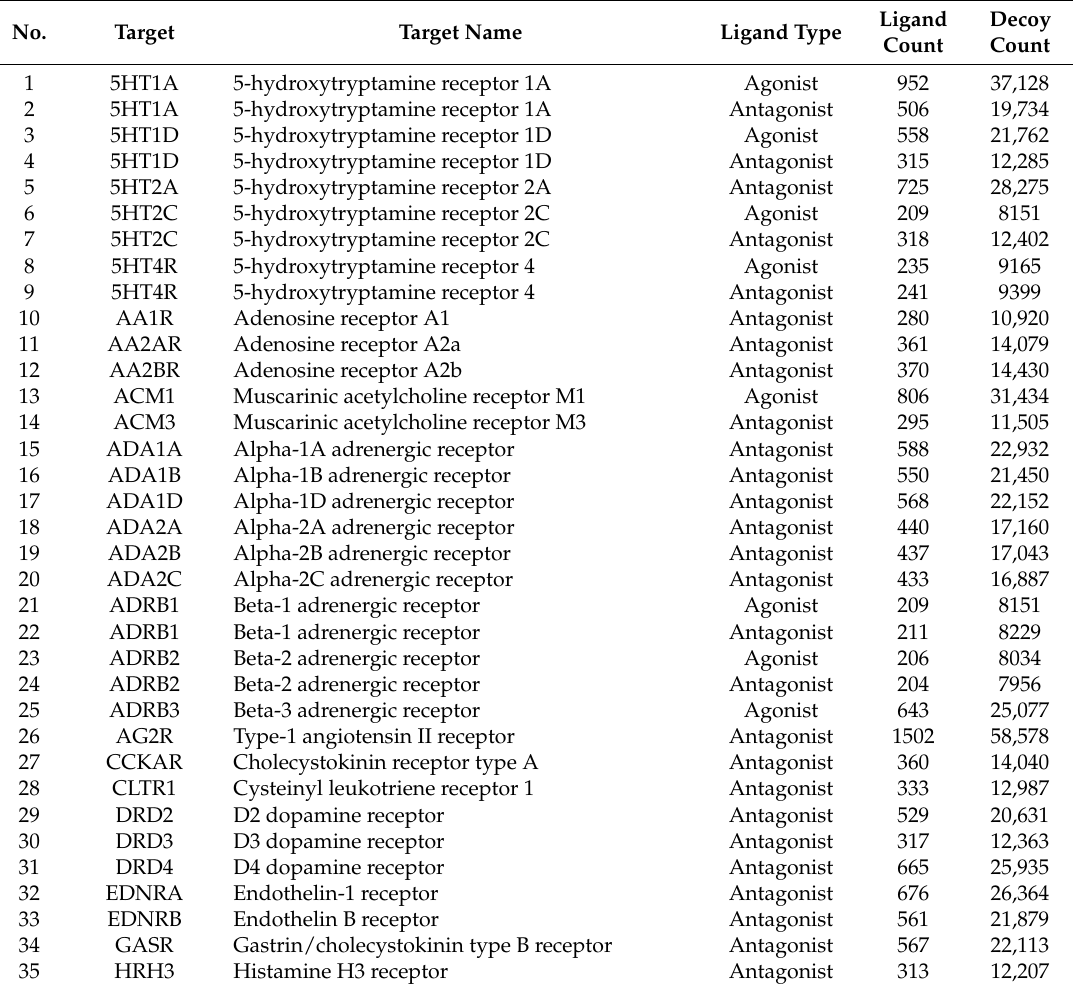
Table 3. The 42 GLL/GDD data sets with more than 200